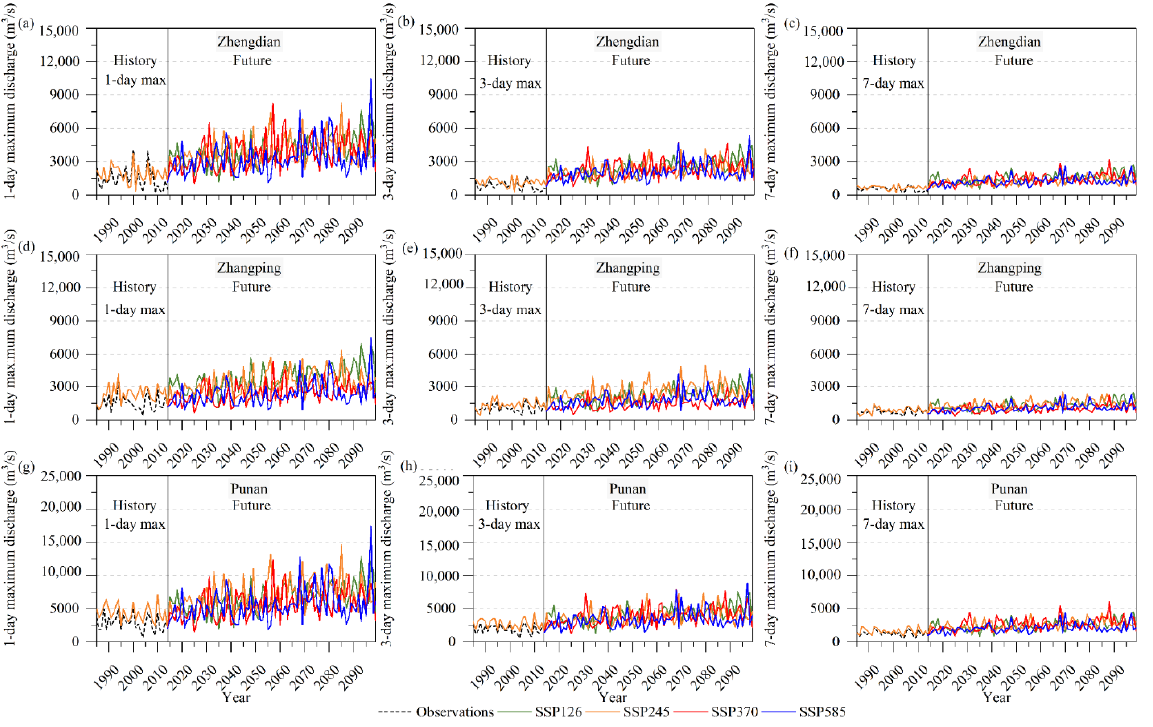
Figure 7. Simulated annual 1-day maximum, 3-day maximum and 7-day maximum river discharges in the historical period and under the future SSP–RCPs at Zhengdian ( a – c ) station, Zhangping sta- tion ( d – f ) and Punan station ( g – i ).